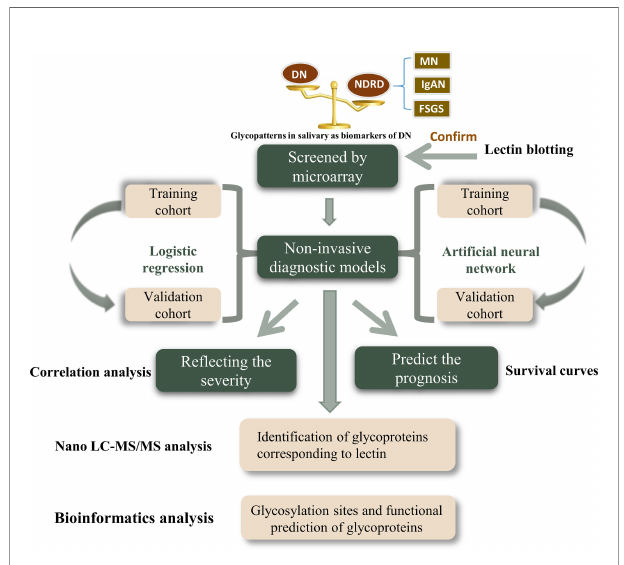
FIGURE 1 | Schematic illustration of the present research. DN, diabetic nephropathy; NDRD, non-diabetic renal disease; MN, membranous nephropathy; IgAN, immunoglobulin A nephropathy; FSGS, focal segmental